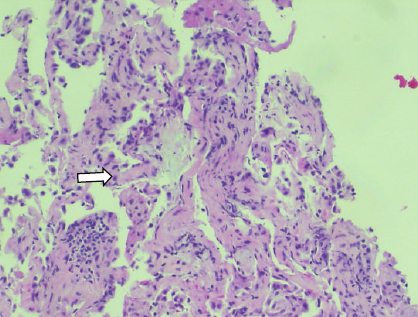
Figure 2: Lung biopsy (mild chronic interstitial pneumonitis with focal fibroblastic foci, consistent with organizing pneumonia; stains for fungi and AFB were negative) (see